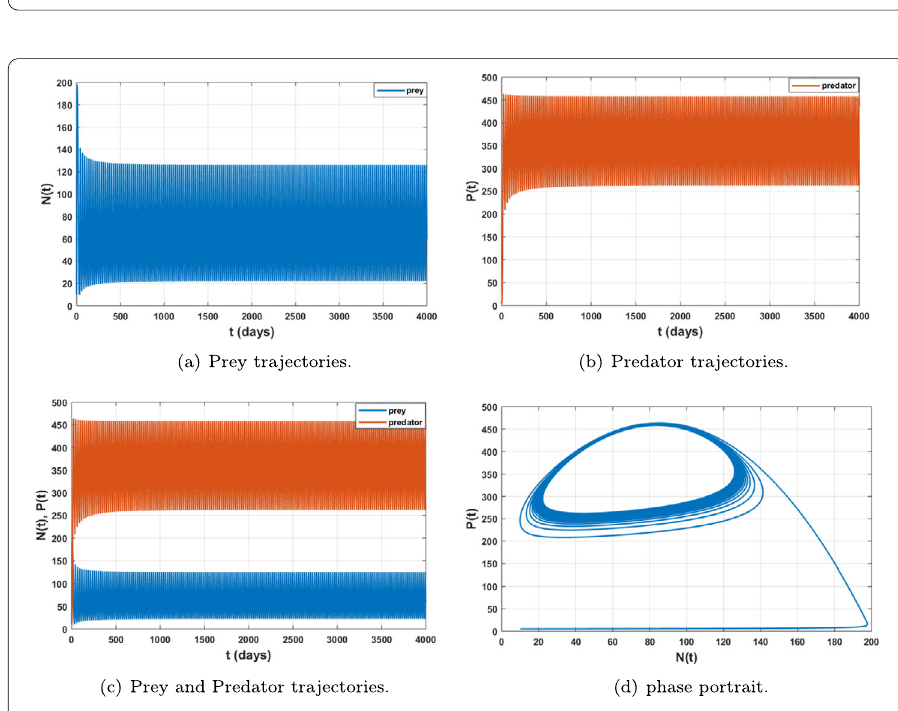
Figure 8 Limit cycle behavior of the solution of system ( 2.3) at the coexisting equilibrium E + 3 corresponding to δ 1 =